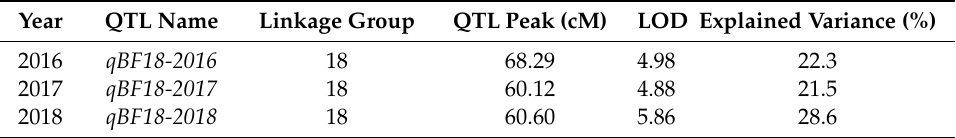
Figure 3. Quantitative trait loci (QTL) of berry firmness on the genetic linkage map of three years. Table 5. The results of QTL mapping for berry